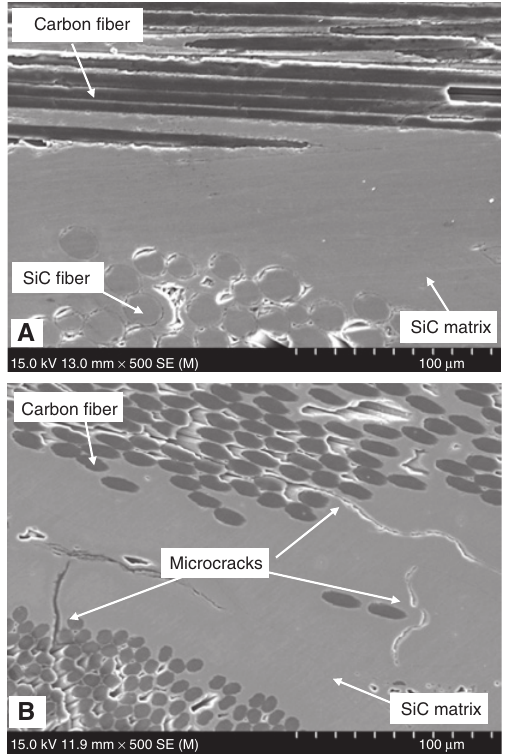
Figure 1 SEM images of polished morphologies of the SiC matrix in both composites: (A) SiC matrix in sample A; (B) SiC matrix in sample